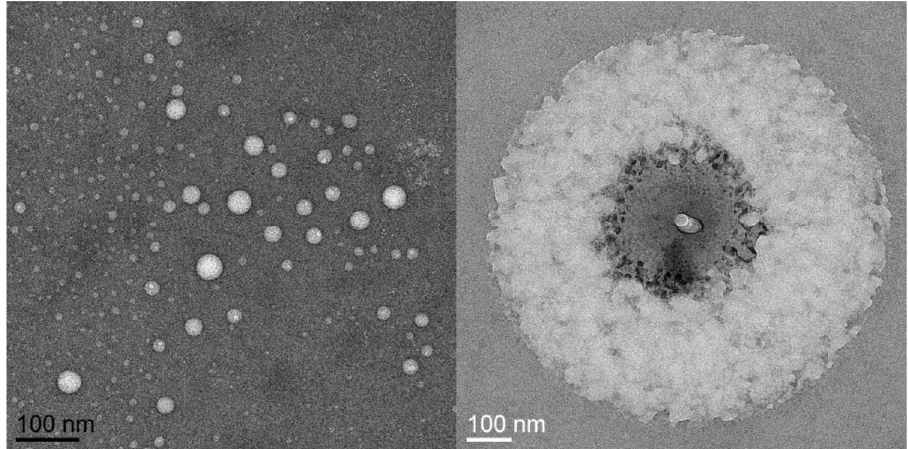
Figure 1. Liposomes as contained in the liposomal multivitamin/mineral product in the present in- vestigation. Images were captured using cryogenic electron microscopy. Images courtesy of Dr. Da- vid Belnap, EM Core Lab, University of